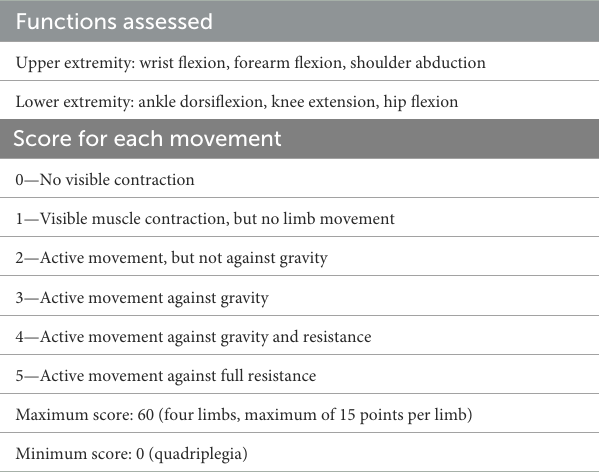
TABLE 1 Medical research council (MRC) scale for muscle examination. Functions